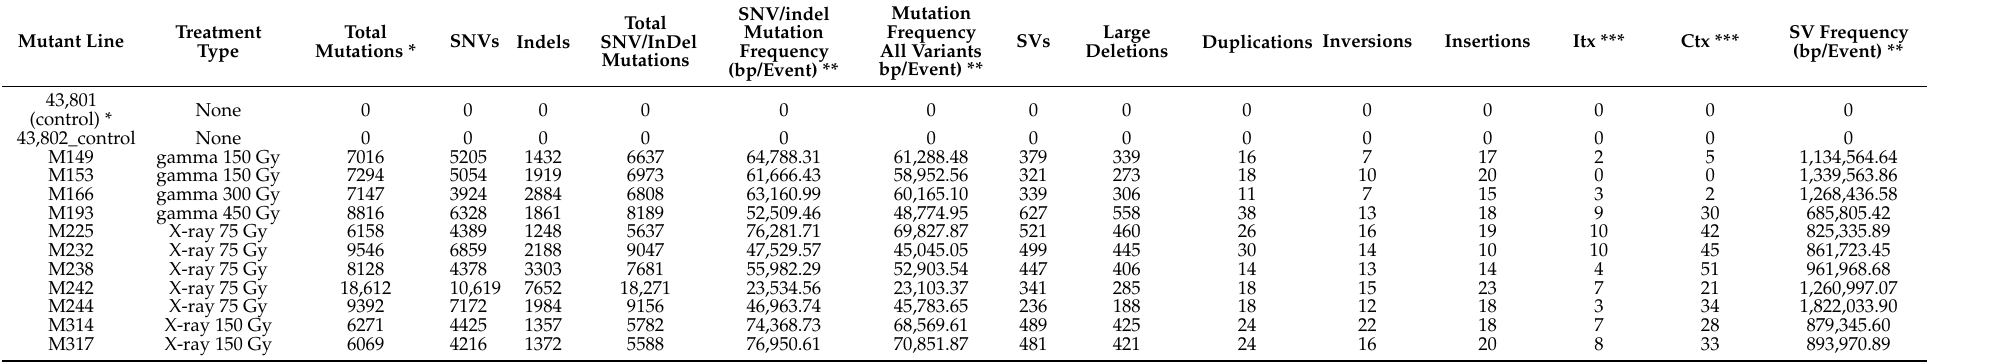
Table 3. Distribution of all predicted induced mutations identified in mutant